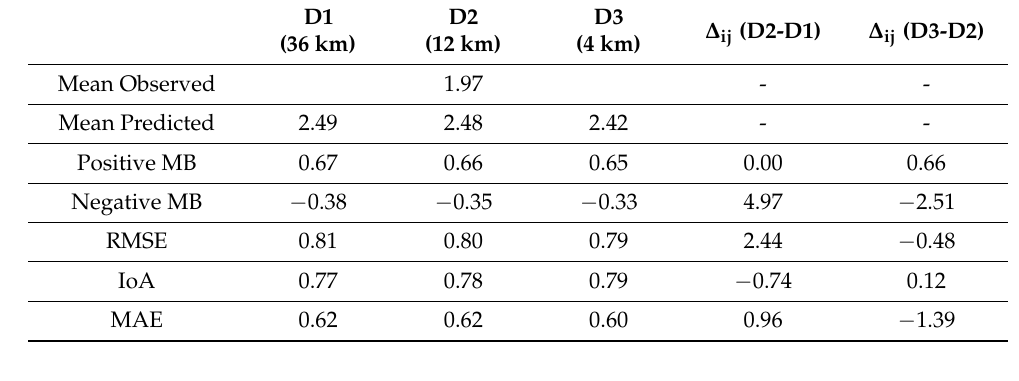
Table 6. Annual mean precipitation statistical analysis (mm/day).